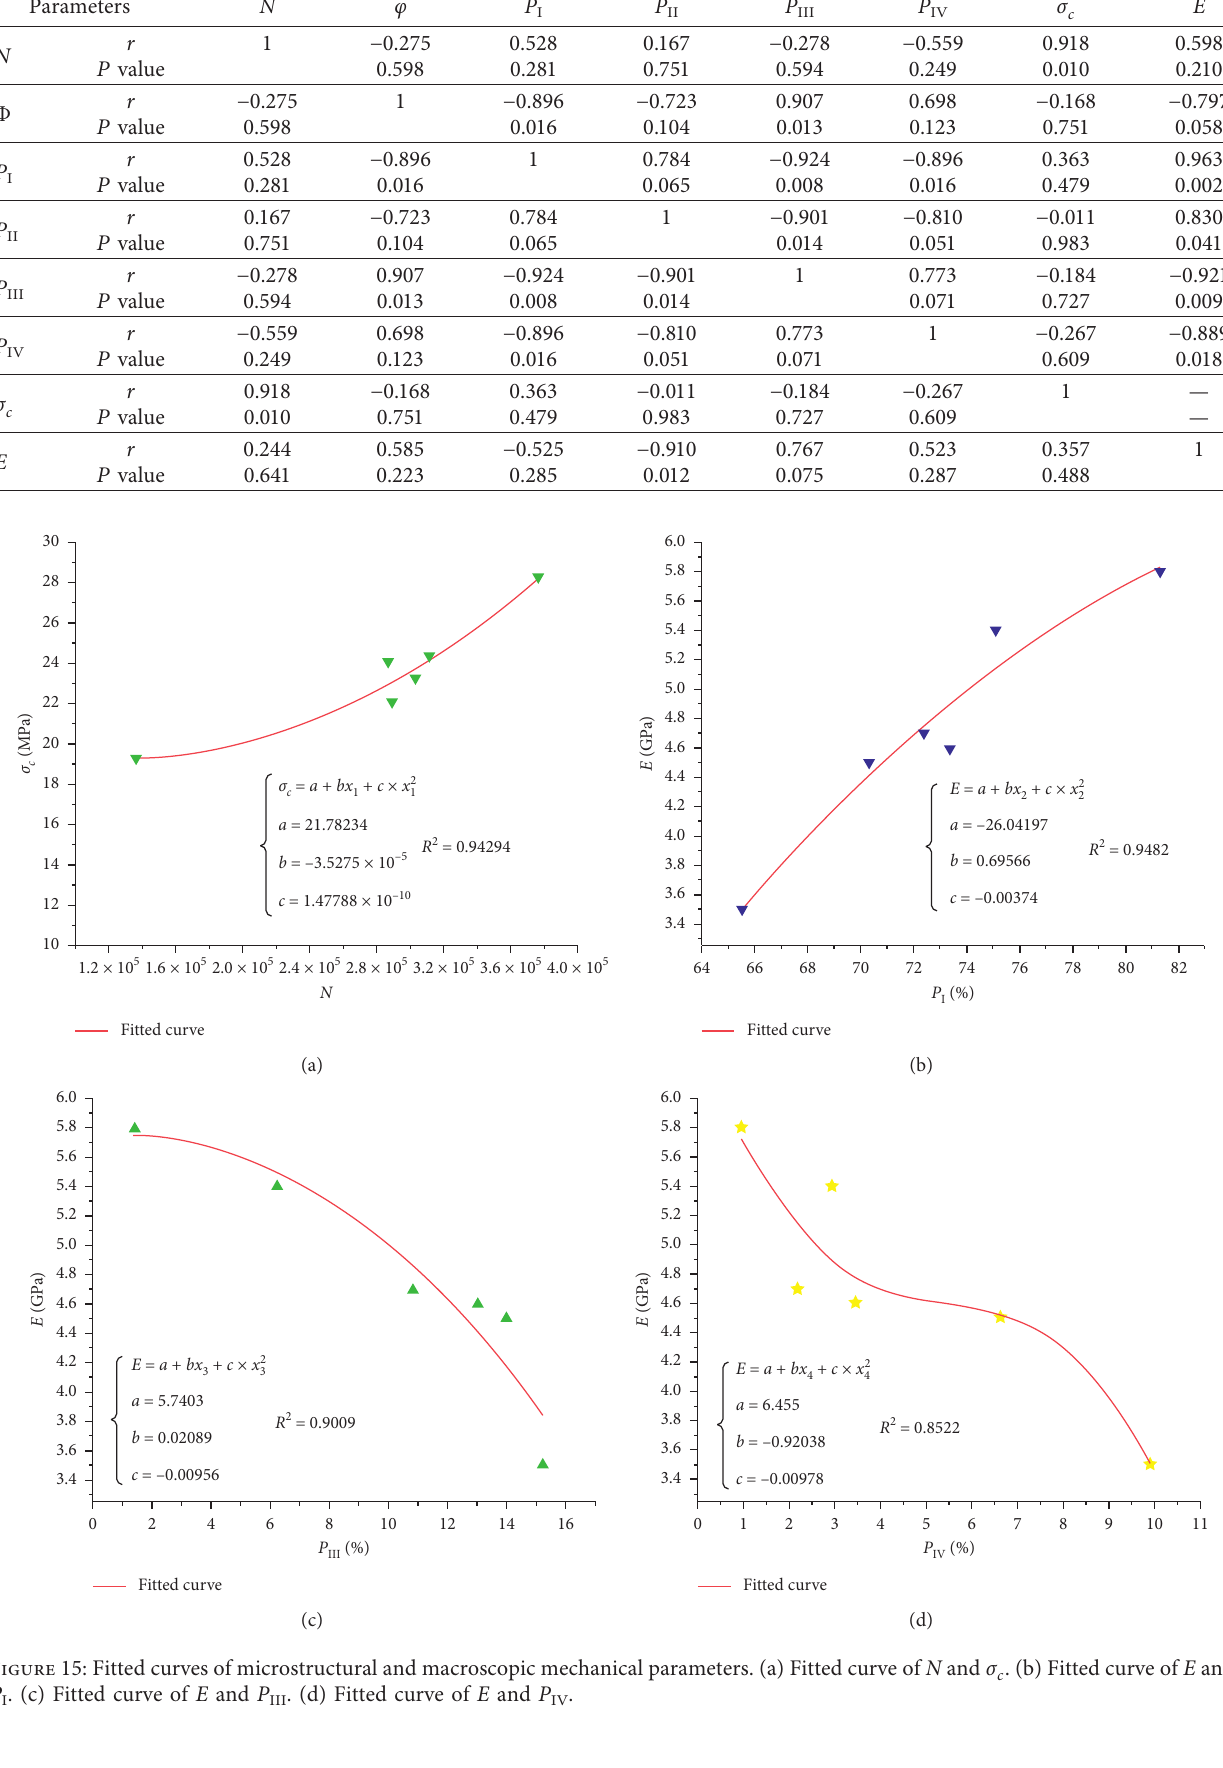
c . (b) Fitted curve of E and